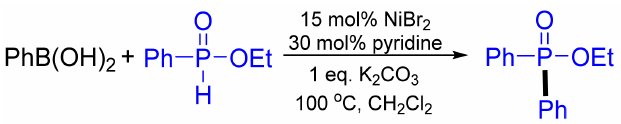
Figure 26. Reaction of phenylboronic acid with ethyl